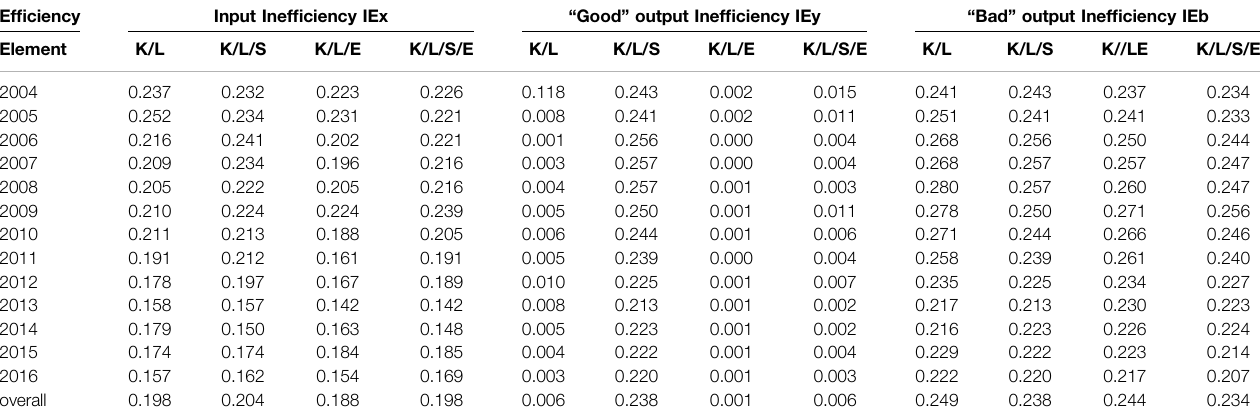
TABLE 2 | Results of inef fi ciency level decomposition. Ef fi ciency